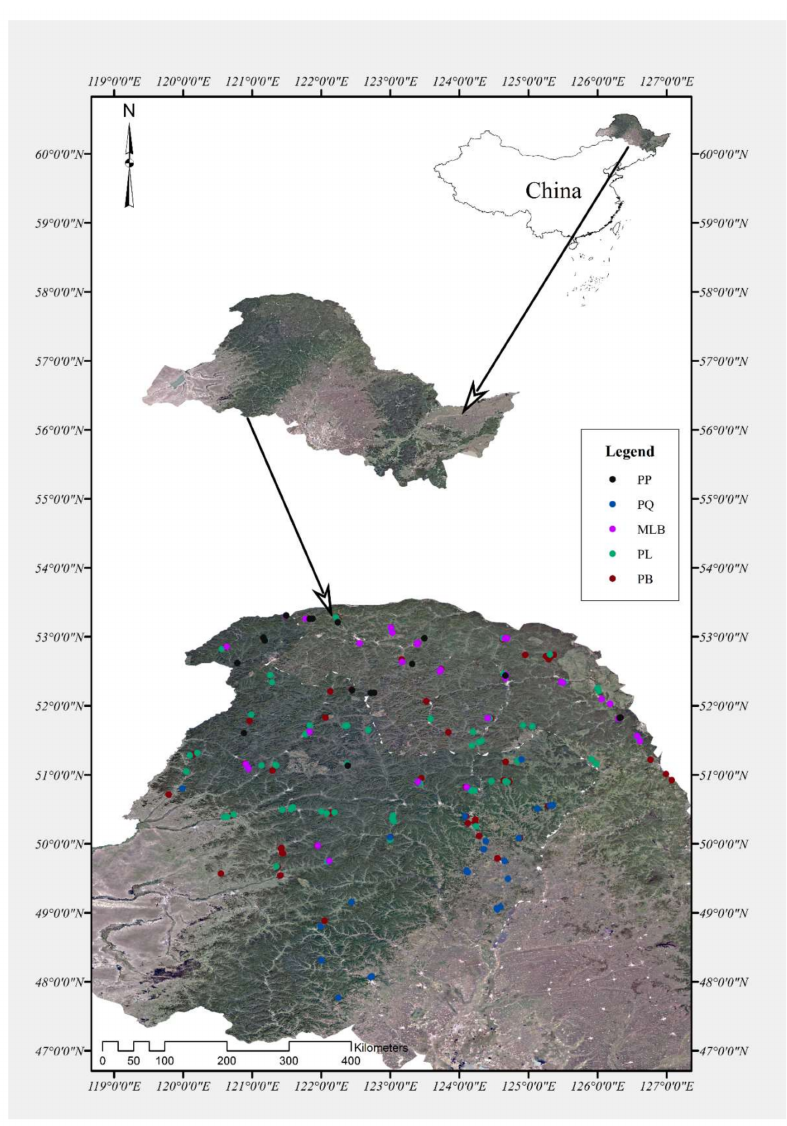
Figure 1. Map of the study area and investigated plots of five forest types in the Daxing’an Mountains. PP = pure Pinus sylvestris L. var. mongolica Litv. forest, PQ = pure Quercus mongolica Fisch . ex Ledeb. forest, MLB = Larix gmelinii (Rupr.) Kuzen and Betula platyphylla Suk. mixed forest, PL = pure Larix gmelinii (Rupr.) Kuzen forest, PB = pure Betula platyphylla Suk.